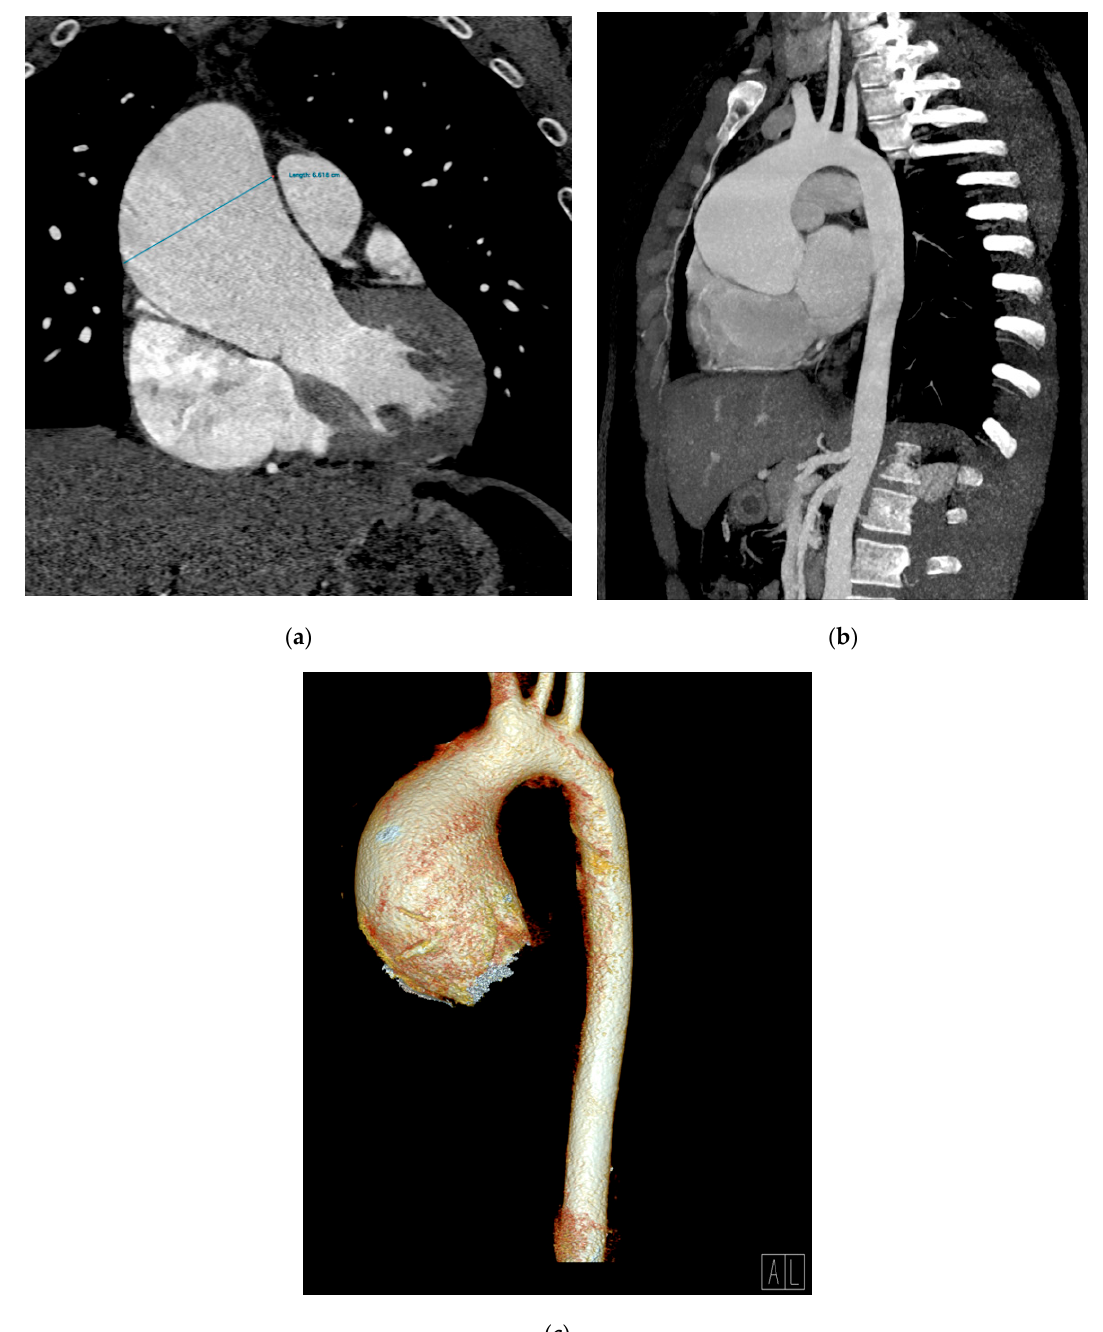
Figure 3. An angio CT aortic scan. Aneurysmal dilatation of ascending aorta (66 mm diameter); coronal multiplanar reconstruction (MPR) ( a ), oblique–sagittal maximum-intensity projection (MIP) reconstruction ( b ), and a 3D volume rendering technique (VRT) reconstruction ( c ).